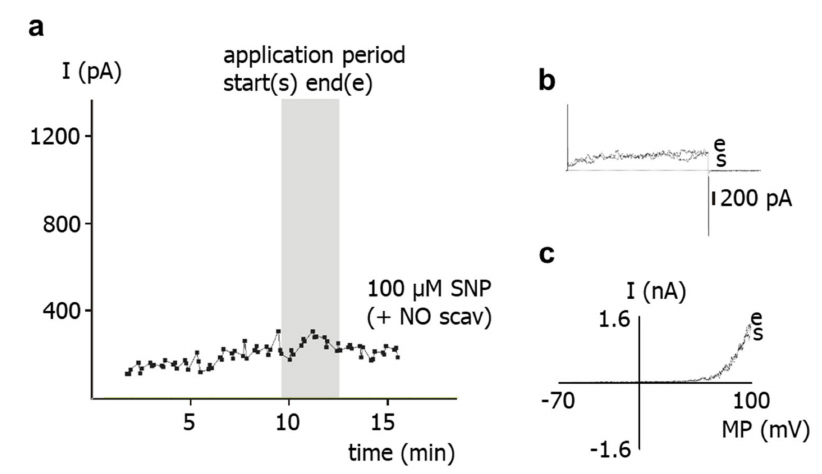
Figure 2. Effect of the NO-donor SNP on the outward current of rat tail artery smooth muscle cells in the presence of the NO-scavenger hydroxocobalamin. ( a ) Example of the time course of the effect of SNP in the presence of 1 mM hydroxocobalamin (NO scav) on the outward current. The application period is shown as grey area; start of application is marked as (s), end of application as (e). The current was elicited with use of a 500 ms-long voltage step from a holding potential of − 40 mV to a test potential of +70 mV. ( b ) Examples of traces of the outward current elicited with use of a 500 ms-long voltage step from a holding potential of − 40 mV to a test potential of +70 mV at the start (s) and at the end (e) of the application of SNP in the presence of 1 mM hydroxocobalamin. ( c ) Examples of current–voltage (I–MP) relationships of outward current elicited with use of a 1.5 s-long voltage ramp from a holding potential of − 40 mV in the voltage range from − 70 to +100 mV at the start (s) and at the end (e) of the application of SNP in the presence of 1 mM hydroxocobalamin.